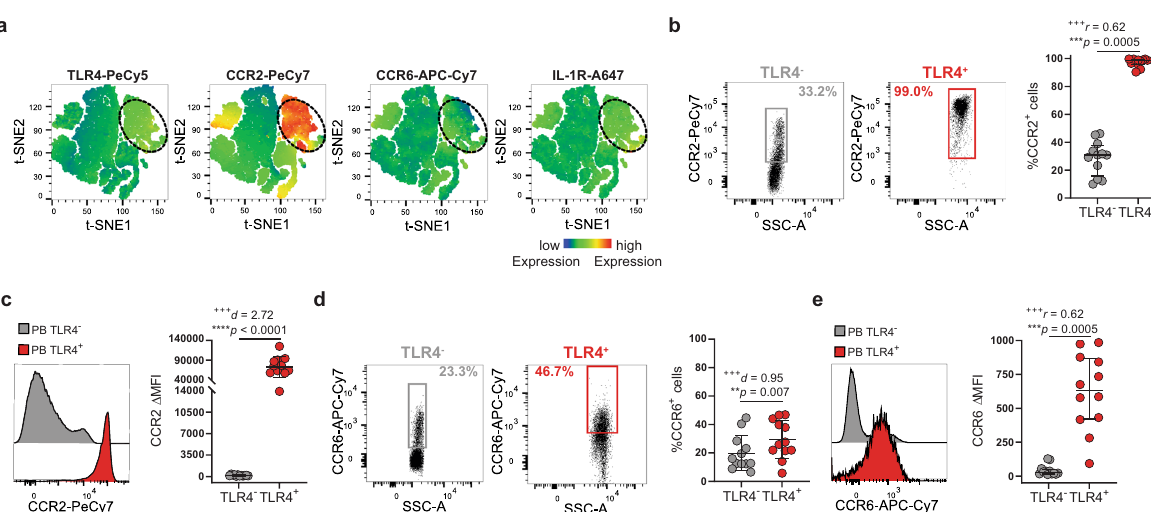
Fig. 7 TLR4 + T cells express in fl ammatory chemokine receptors CCR2 and CXCR6. a t-SNE plots of peripheral blood total CD4 + T cells. The color indicates cell expression levels of labeled markers (TLR4, CCR2, CCR6, IL-1R). Circle demarks TLR4 + cells ( n = 6 RA patients). b , c Representative plots and cumulative graph ( n = 12 RA patients) of CCR2 b frequency and c Δ MFI in TLR4 + (red) and TLR4 − (gray) T cells. d , e Representative plots and cumulative graph ( n = 12 RA patients) of CCR6 d frequency and e Δ MFI in TLR4 + (red) and TLR4 − (gray) T cells. Δ MFI was calculated to correct for the distinct auto fl uorescence of the TLR4 − and TLR4 + T-cell populations. Δ MFI was calculated by subtracting the fl uorescence intensity minus one (FMO) from median fl uorescence intensity (MFI) for each given marker. Data are presented as mean ± SD, for parametric statistical tests, or median ± IQR, for non-parametric statistical tests. Sample normality distribution was tested by using D ’ Agostino & Pearson normality test. P values **** p ≤ 0.0001, *** p ≤ 0.001, ** p ≤ 0.01, * p ≤ 0.05 were determined by ( b , e ) Wilcoxon matched-pairs rank test and ( c , d ) Paired t test. Effect size measures +++ high, ++ medium, + small were determined by ( b , e ) r – correlation coef fi cient r and ( c , d ) d – Cohen ’ s